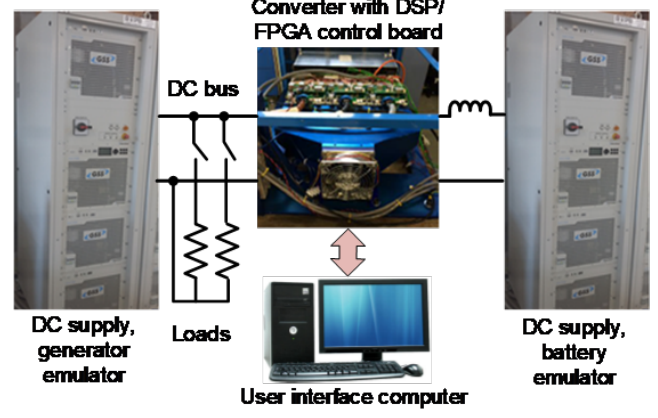
Figure 18. Block diagram of the laboratory experimental